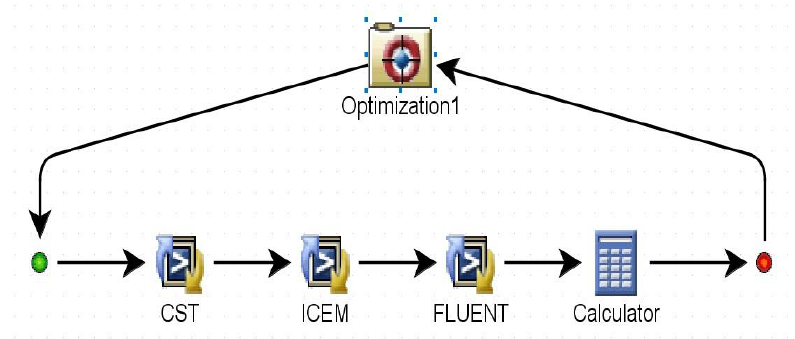
Figure 7. Isight integration.